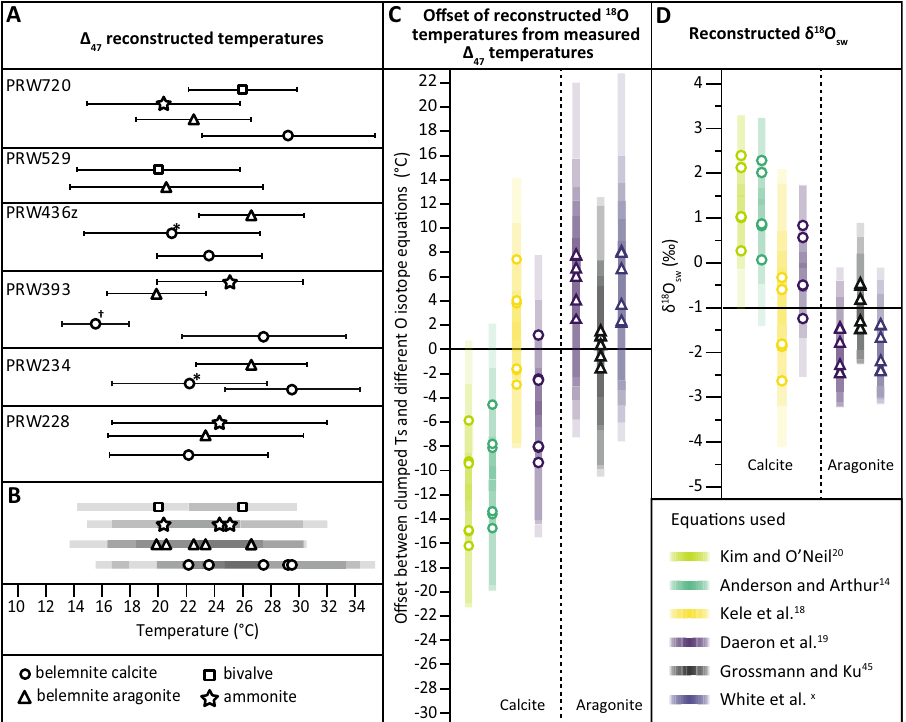
Figure 2. ( A ) Reconstructed temperatures from clumped isotopes (each based on 10 or more replicates) for all samples analysed (all from the Phaeinum subzone), displayed by type (rostrum, phragmocone, ammonite and bivalve) and with accompanying samples from the same block. Error bars indicate the 95% confidence interval. † = sample from apical area, including early diagenetic infill. * = diagenetic sparry calcite from phragmocone chamber spaces. The calcites marked †* are not included in any following analyses of the data (e.g. Figure 2B, C or Fig. 3). ( B ) All samples grouped together to demonstrate the range spanned over this single subzone, not including the samples marked †*. ( C ) Offset of reconstructed 18 O temperatures (for the different equations) from measured clumped isotope temperatures. Error envelope = maximum possible offset between clumped and stable temperatures based on the 95% CL level for clumped isotope temperatures and the SD for measured oxygen